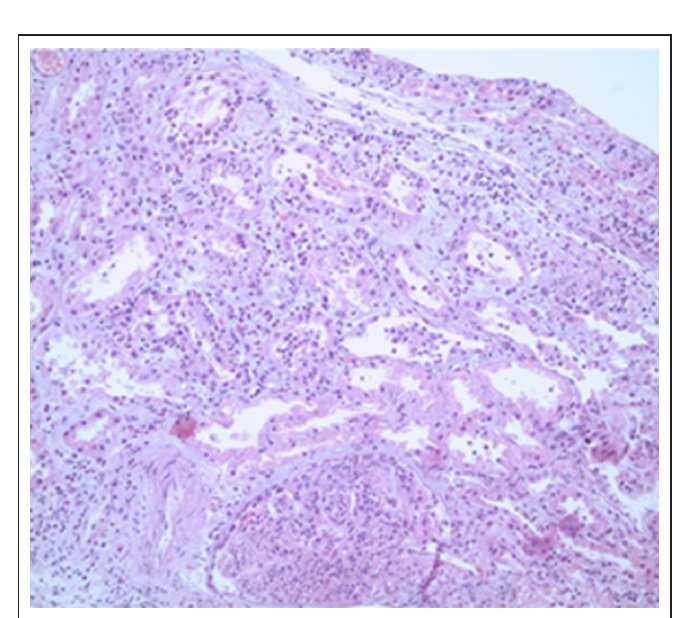
Figure 1. Diffuse exudative endocapillary and extracapillary glomerulonephritis. Note accompanying tubulitis and acute interstitial